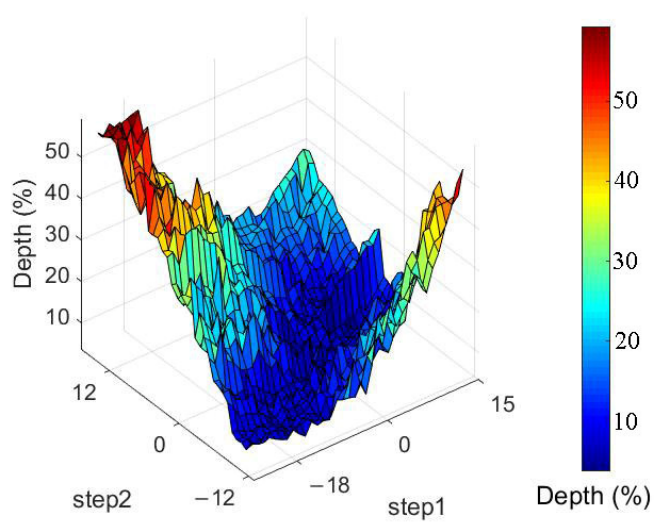
Figure 4. Diagram of motor scan.